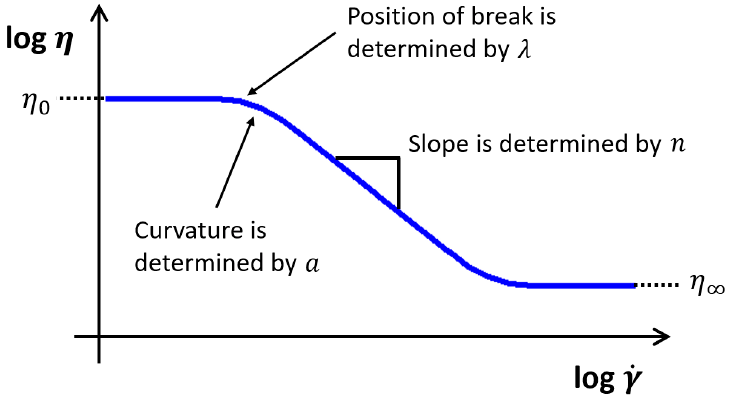
Figure 7. The effect of relaxation time ( λ ), transition control factor ( a ) and power law index ( n ) on the viscosity versus shear-rate curve in Carreau–Yasuda viscosity model. Power law index n ( T ) is another dimensionless parameter in the model that describes the slope of the rapidly decreasing region of viscosity versus shear rate curve (see Figure